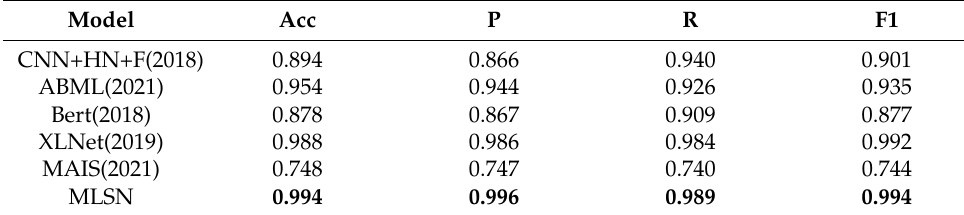
Table 2. Evaluation results of each model on Pun of the Day dataset.